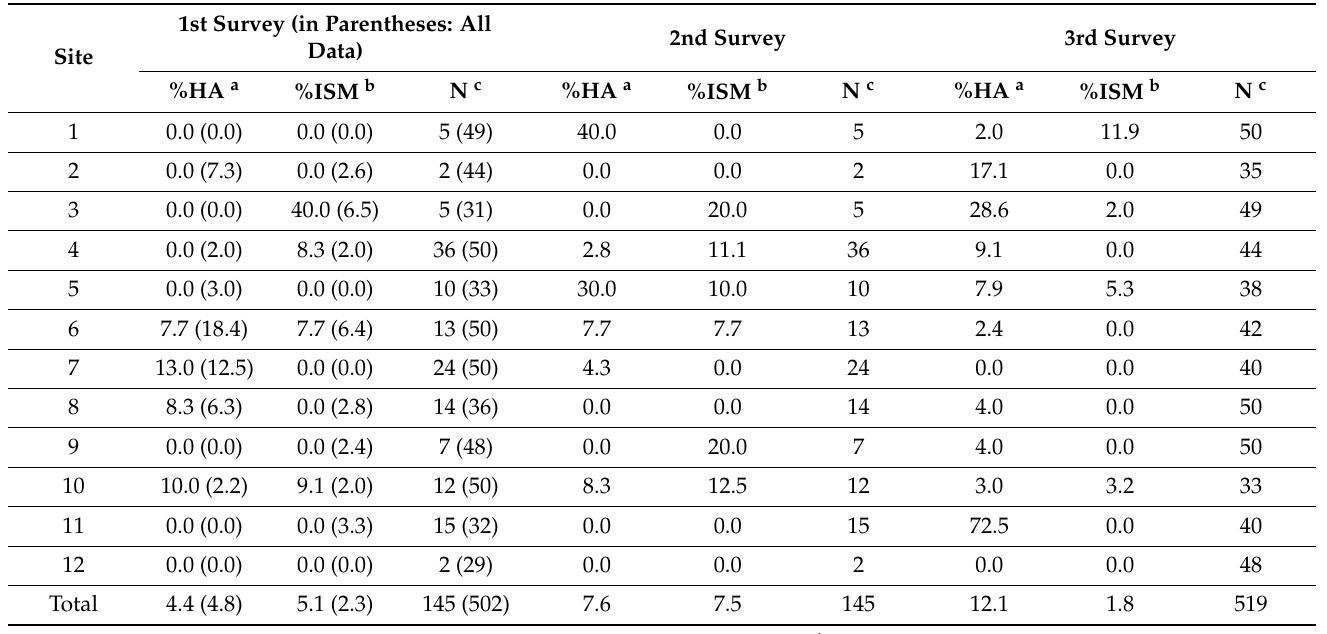
Table 6. Percentage of highly annoyed (%HA) and percentage of insomnia (%ISM) among respon- dents and the total number of responses collected at each survey